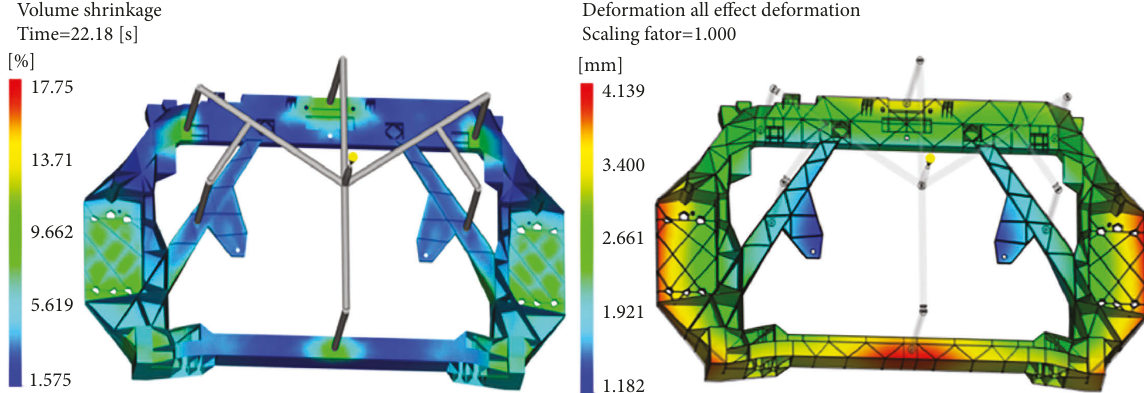
Figure 8: Volume shrinkage and warpage analysis results of the 6 gate gating systems.